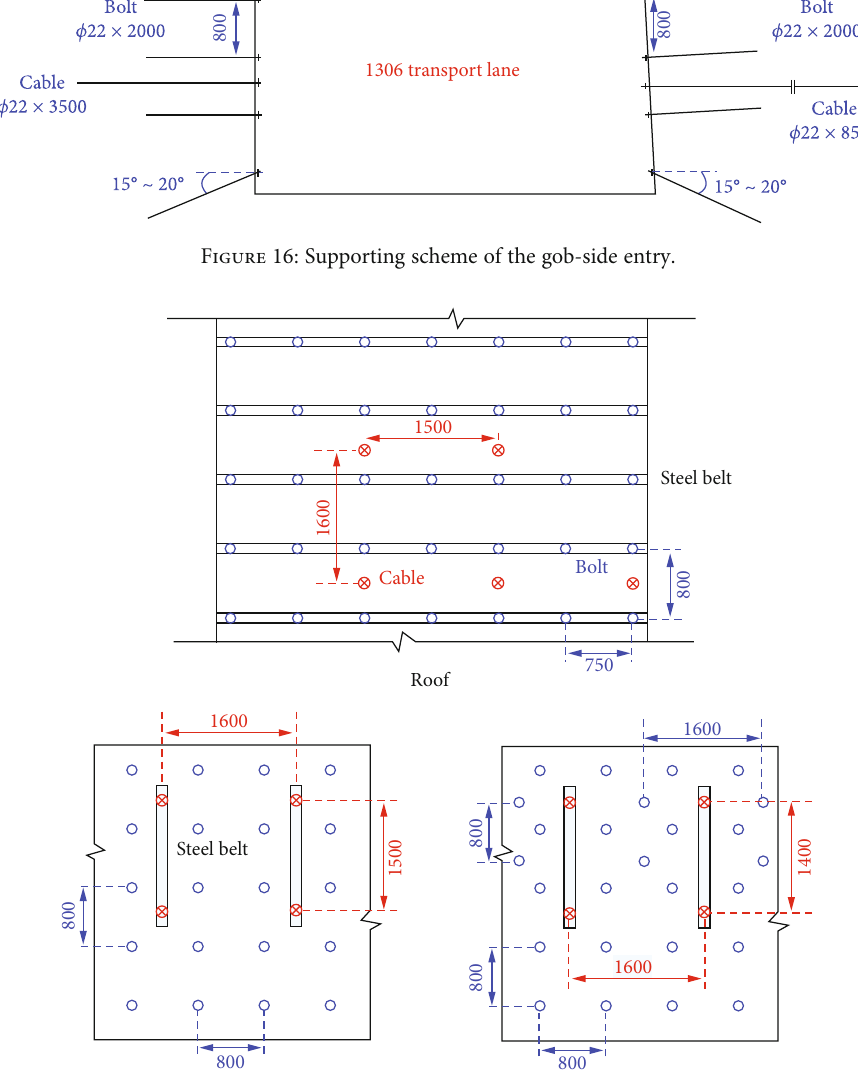
Figure 17: Arrangement of rock bolts and cable bolts in the gob-side